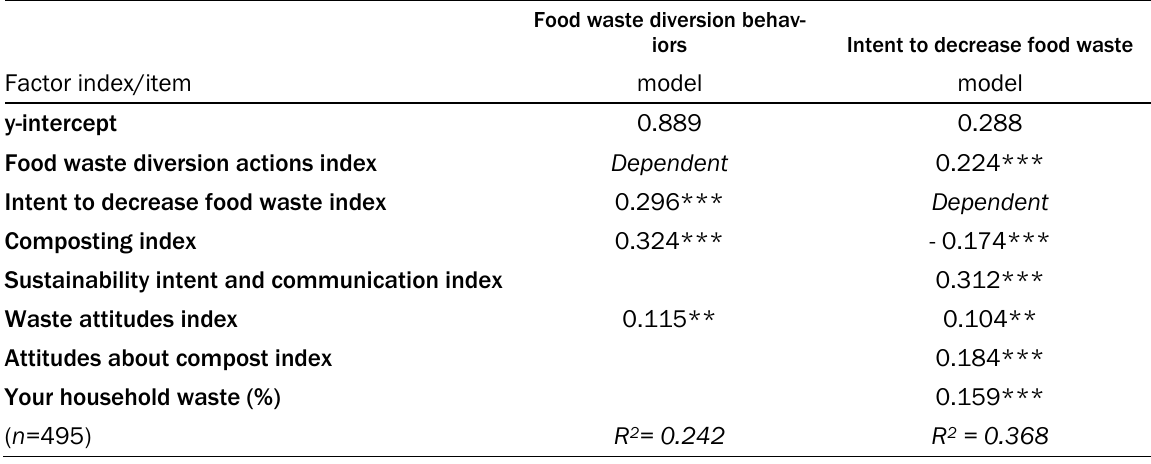
Table 2. Linear Regression Models Indicating Relationships Between Measured Factors and Both “Intent To Decrease Food Waste” and “Reported Food Diversion